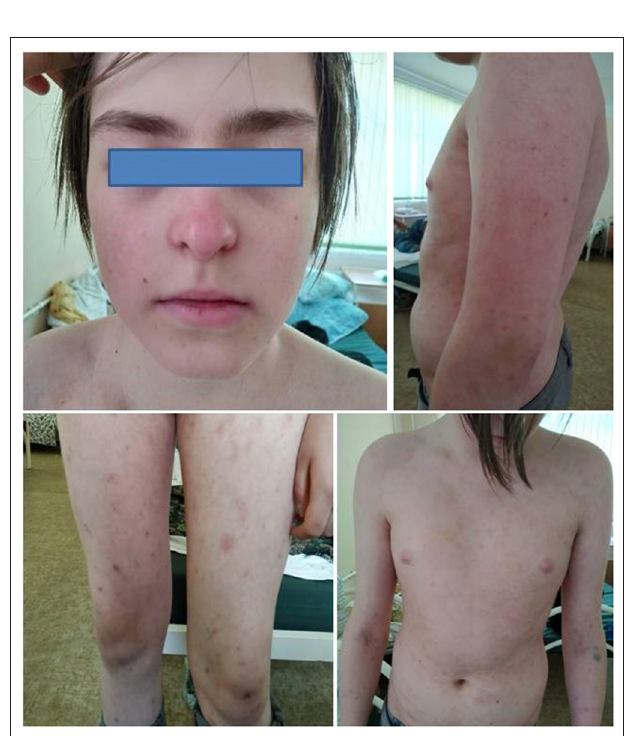
additional treatment (rituximab or synthetic DMARDs). Twin